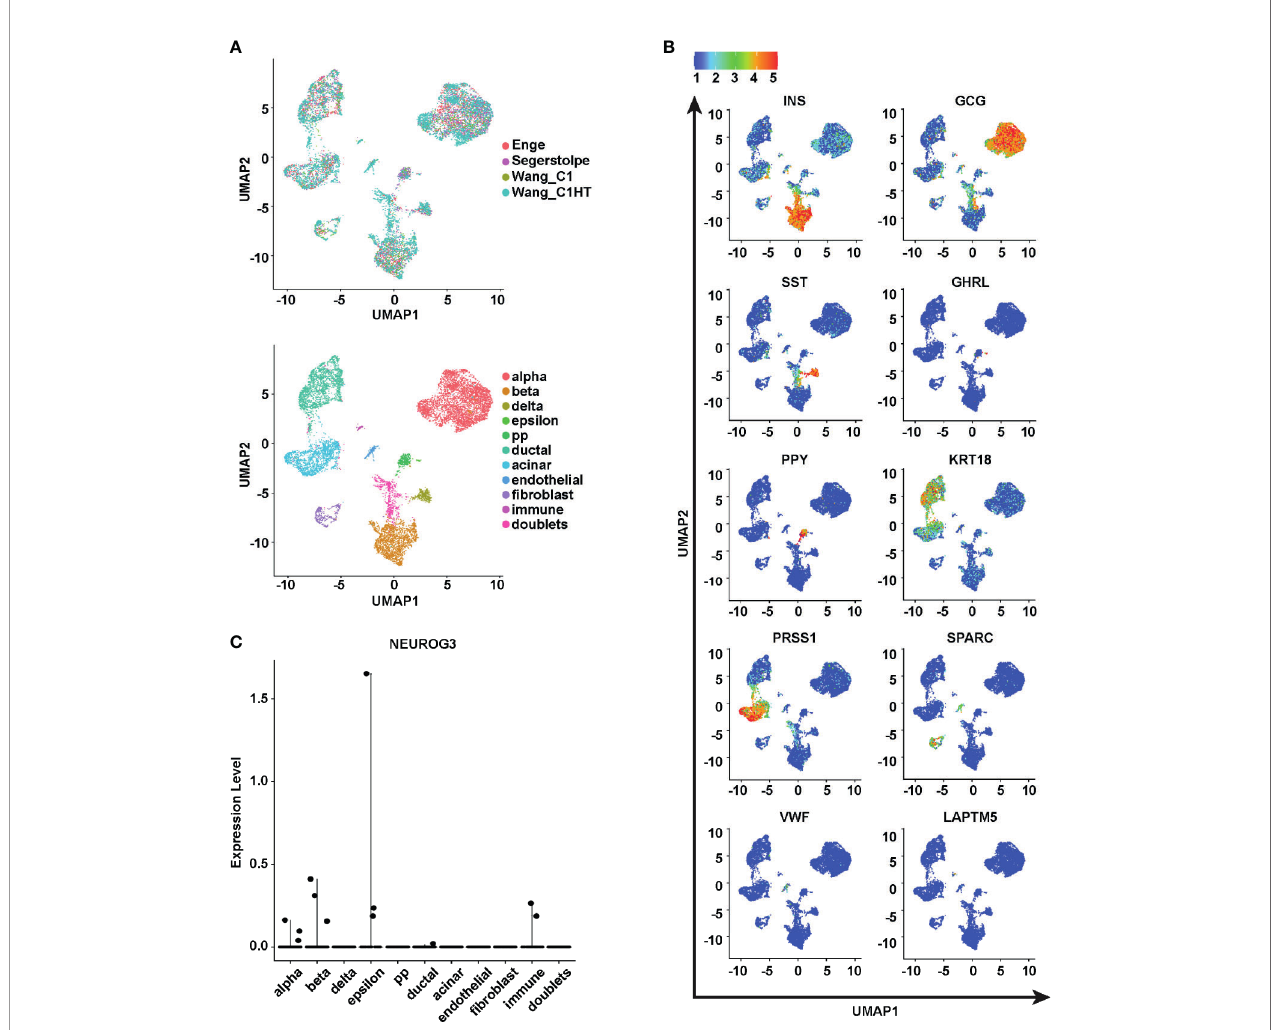
FIGURE 1 | The identi fi cation of NEUROG3+ cells from 11,174 postnatal human pancreatic cells. (A) Uniform Manifold Approximation and Projections (UMAPs) are used to visualize the single-cell RNA-seq data post alignment. Top panel, cells are colored according to their study sources. Bottom panel, cells are colored according to cell types. (B) Relative expression of known pancreatic cell-type markers. The color scale is based on normalized expression values of transcripts in each UMAP panel. (C) Scatter plot exhibits the expression levels of NEUROG3 in different